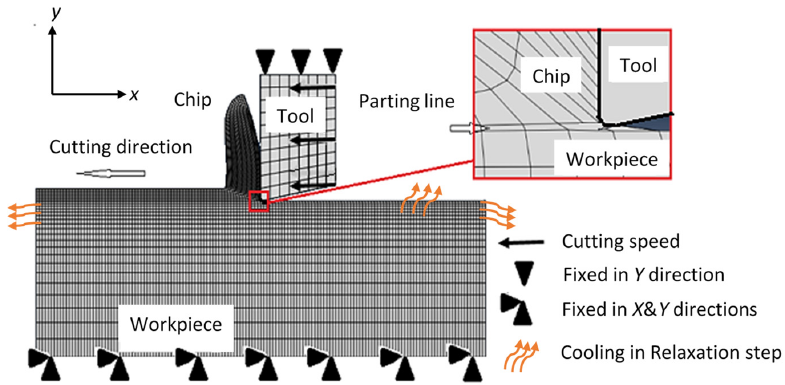
Figure 3. Orthogonal cutting model. Chip formation and damage evolution.